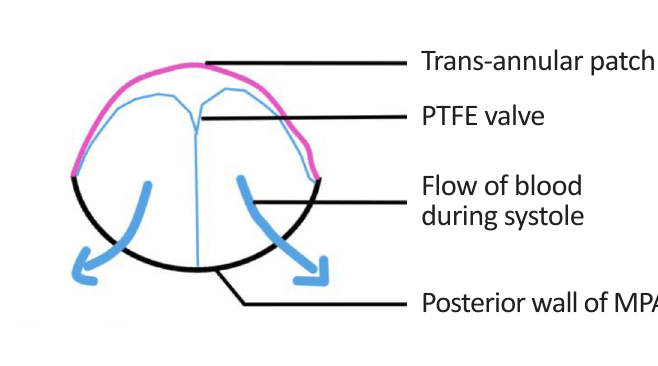
Fig. 1F – Cross-sectional view of PTFE membrane valve showing blood flow during systole. MPA=main pulmonary artery;